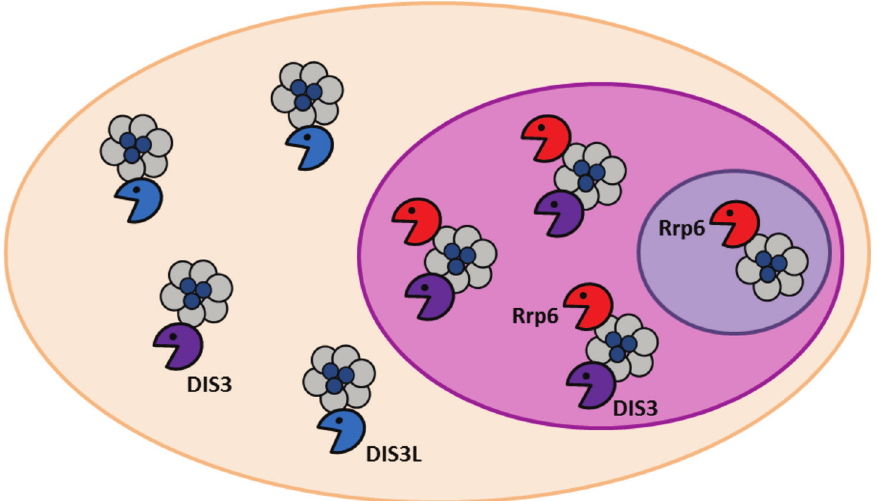
Figure 3. Sub-cellular localisation of the different human exosome complexes. The non-catalytic exosome core (grey) is present in the nucleus, cytoplasm and nucleolus but associates with different 3' to 5' catalytic subunits depending on the compartment. In the nucleus the exosome associates simultaneously with DIS3 (purple) and Rrp6 (red). In the cytoplasm the core associates with the cytoplasmic-restricted DIS3L (blue) and separately with DIS3 but in lower amounts. In the nucleolus the exosome binds only to Rrp6. It